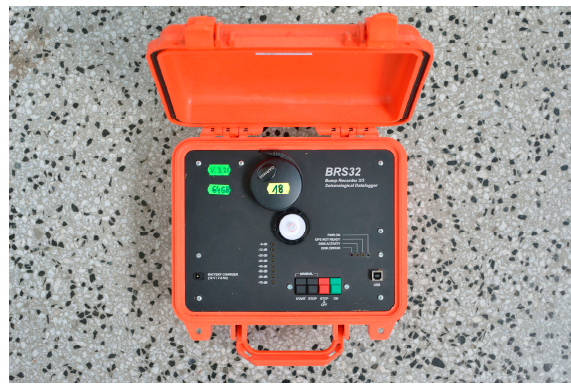
Figure 1. Universal seismic apparatus BRS32.